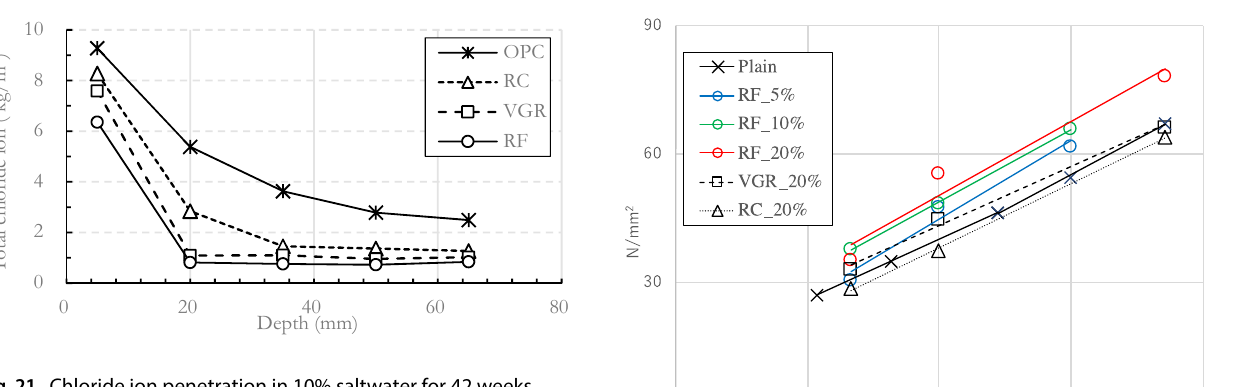
Fig. 21 Chloride ion penetration in 10% saltwater for 42 weeks